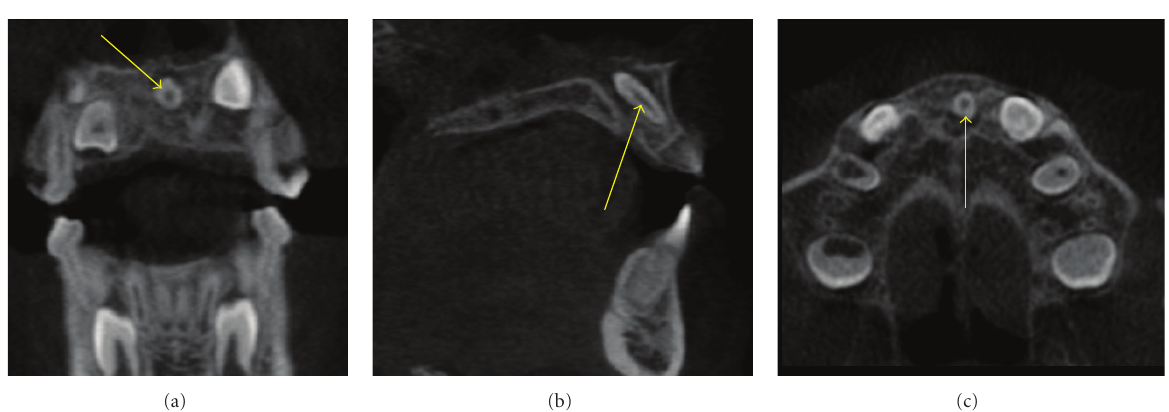
Figure 1: An impacted mesiodens (arrows) angulated obliquely such that the crown is towards the floor of the nasal cavity and the root between the roots of the central incisors of the maxilla is seen in this MPR